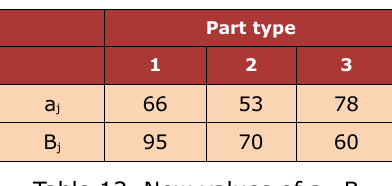
Table 12. New values of a j , B j